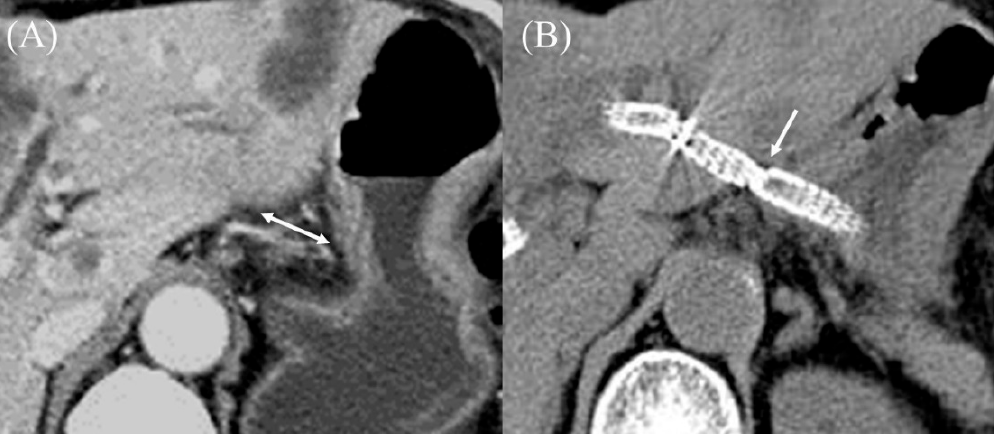
Figure 20. Endoscopic ultrasound-guided hepaticogastrostomy with a Covered BileRush Advance. Pre-procedure contrast-enhanced CT showed a long distance between the gastric body and left hepatic lobe (double arrow) ( A ). Post-procedure CT showed the Covered BileRush Advance fixed the gastric body near the left hepatic lobe by its jagged surface (arrow) ( B ).